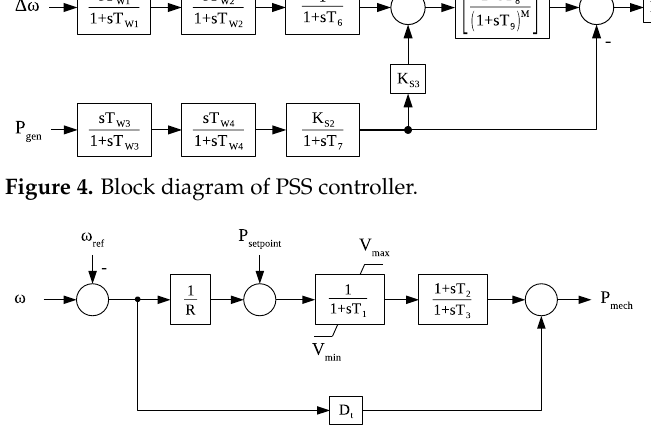
Figure 5. Block diagram of turbine-governor